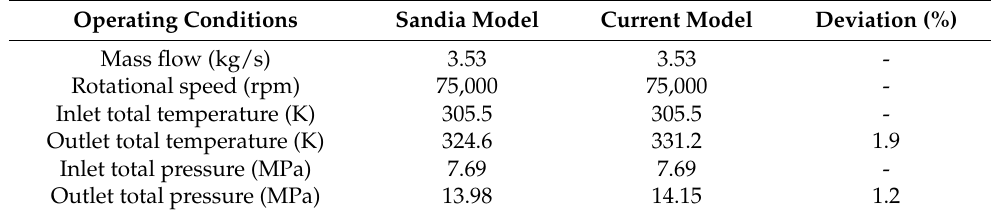
Table 2. Design parameters for the recompression s-CO 2 Brayton